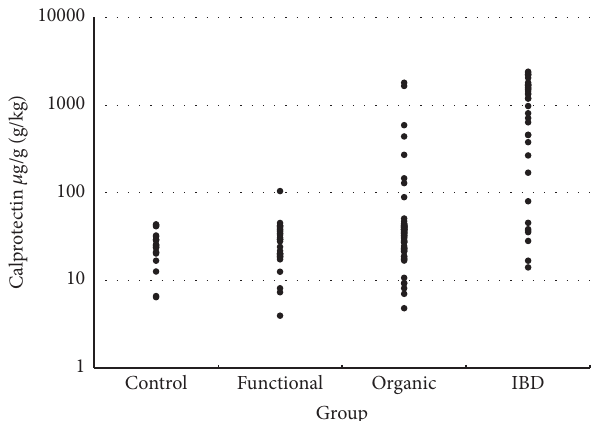
Figure 1: Distribution of fecal calprotectin concentrations (FCC) in the study